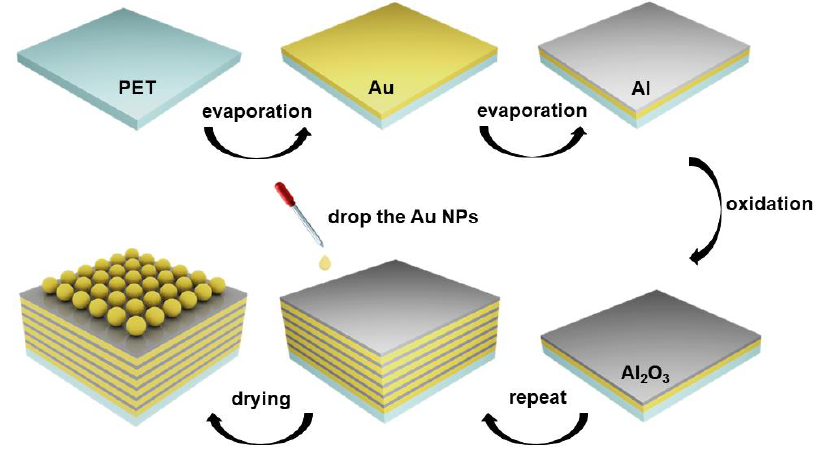
Figure 1. The fabrication of the composite structure